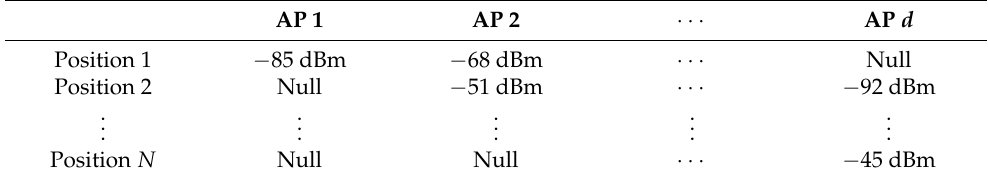
Table 1. Example of WiFi RSSI fingerprint